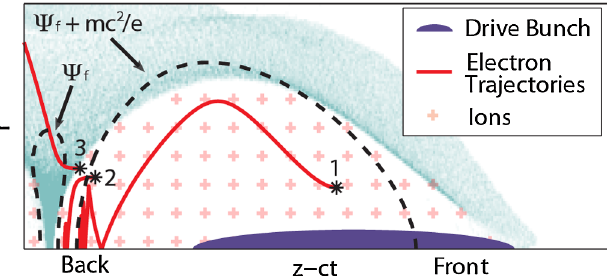
FIG. 1. (Color) An illustration of electron trapping, calculated with OSIRIS [22]. A few example helium electron trajectories overlay an image of lithium electron density (teal), where the asterisks display the ionization location, and the dotted lines represent (cid:2) contours. The electrons that escape their atoms within the (cid:2) f þ mc 2 =e contour (1 and 2) become trapped, while electron 3 slips out of the